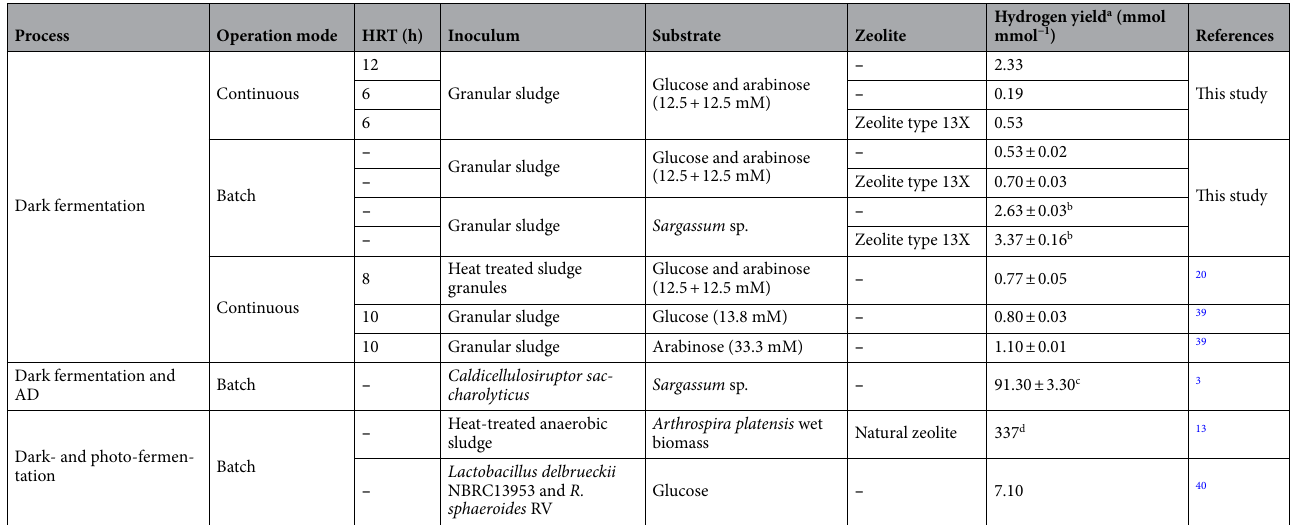
Table 5. Hydrogen yields, pH and COD balance from batch experiments with Sargassum sp. biomass. The results are the average and standard deviations for duplicates. a expressed as mmol H 2 per g of Sargassum sp. (in VS). b at the end of batch experiment assays.